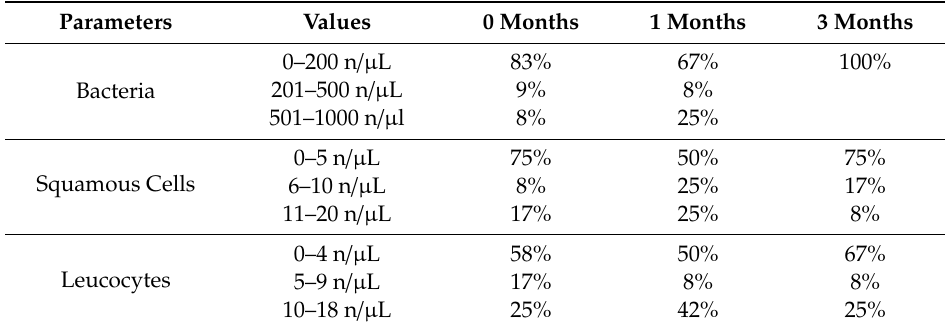
Figure 2. Urinary infections. ( A ) assessment of bacteria at 0, 1, and 3 months in a group of 12 professional basketball athletes. The data are expressed as the mean ± SD. The significance was determined by the one-way ANOVA test: * ( p < 0.05) represents significance compared with 0 months; # ( p < 0.05) represents significance compared with 1 month. ( B ) assessment of squamous cells at 0, 1, and 3 months in a group of 12 professional basketball athletes. The data are expressed as the mean ± SD. The significance was determined by the one-way ANOVA test: * ( p < 0.05) represents significance compared with 0 months; # ( p < 0.05) represents significance compared with 1 month. ( C ) assessment of leukocytes at 0, 1, and 3 months in a group of 12 professional basketball athletes. The data are expressed as the mean ± SD. The significance was determined by the one-way ANOVA test: * ( p < 0.05) represents significance compared with 0 months. The unit of measurement used is n/ μ L (the number of bacteria or leukocytes or squamous cells in one microliter of urine). Table 2. Urine infection parameters. Percentage of bacterial populations, presence of erythrocytes and leukocytes in a group of 12 professional athletes.